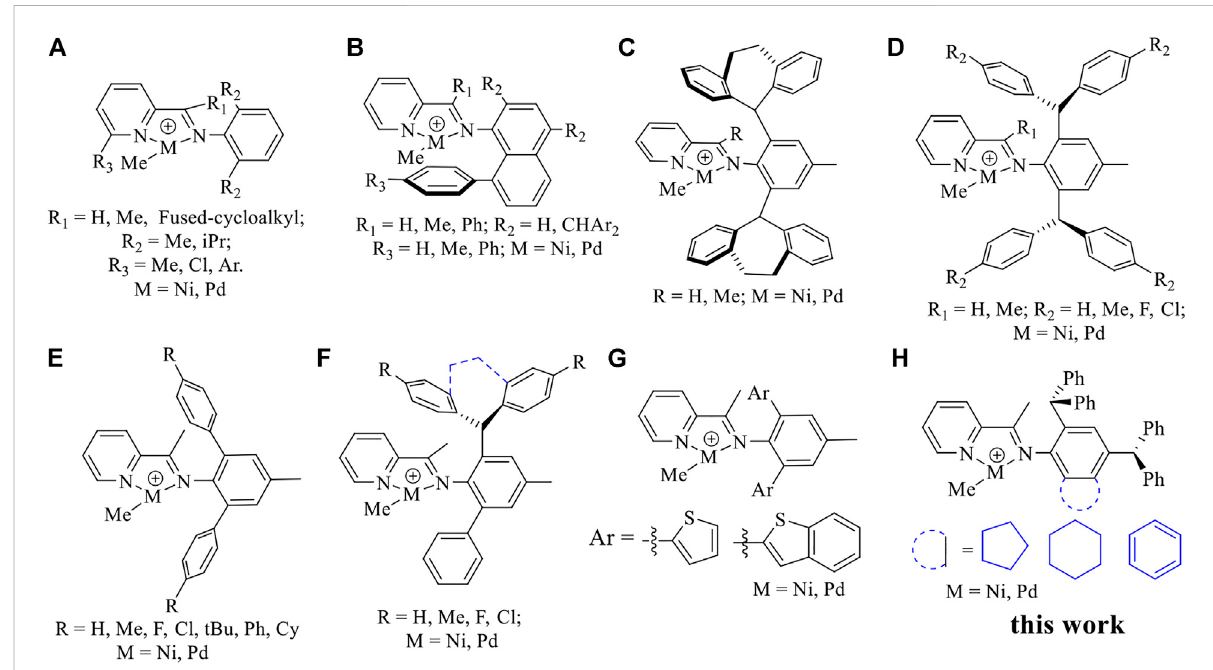
CHART 1 Representative iminopyridine Ni(II) and Pd(II) catalysts (A – G) , and new complexes described in the current work (H) .